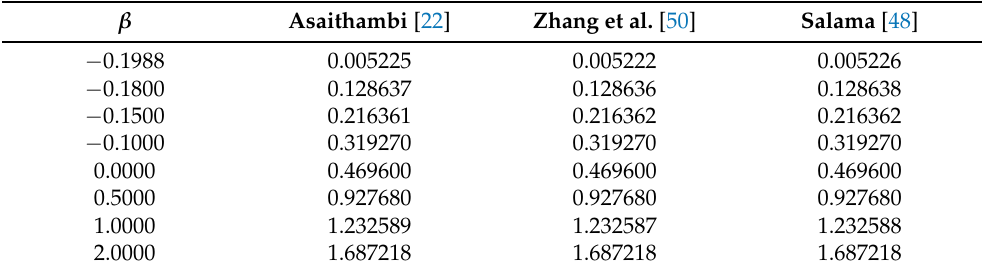
Table 2. Falkner–Skan solutions ( f (cid:48)(cid:48) ( 0 )) for selected values of β ∈ [ − 0.1988,2 ] . β